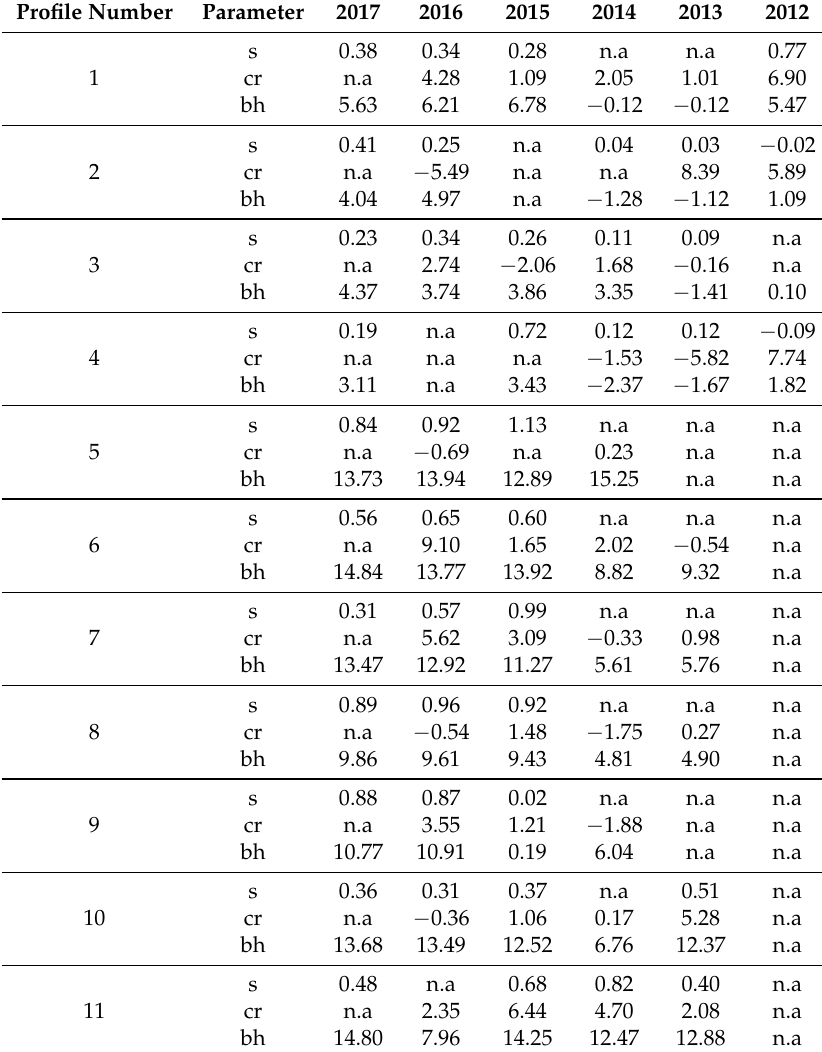
Table 4. Crest retreat ( cr ), bluff height ( bh ) and slope of the bluff-face ( s ) of the 11 profiles during 2012 to the 2017. “n.a” in the table indicates data not